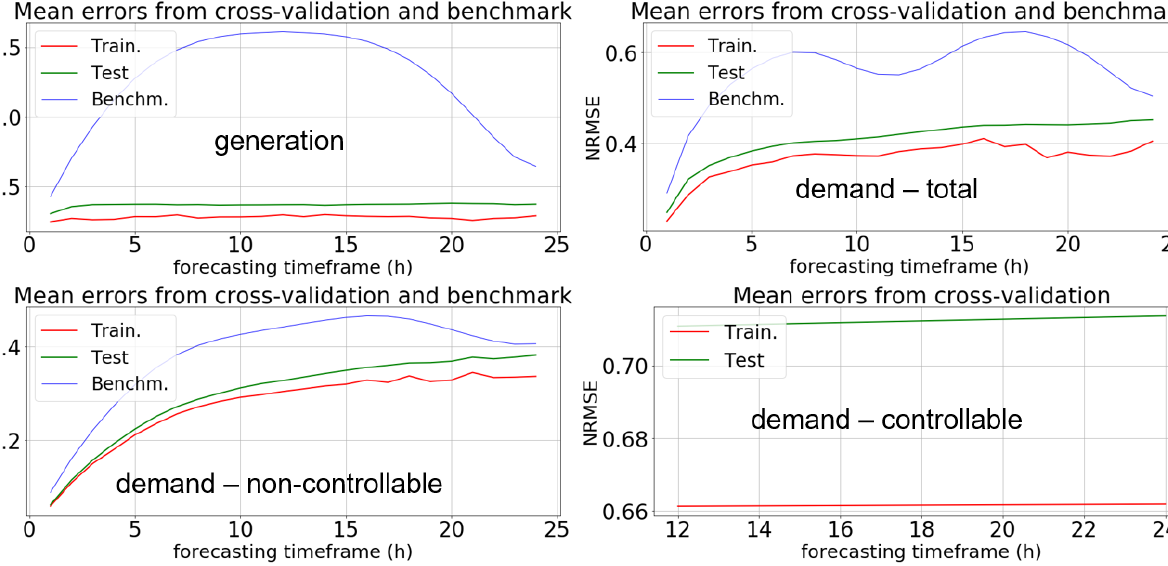
Figure 4. NRMSE per forecasting horizon corresponding to the selected models for